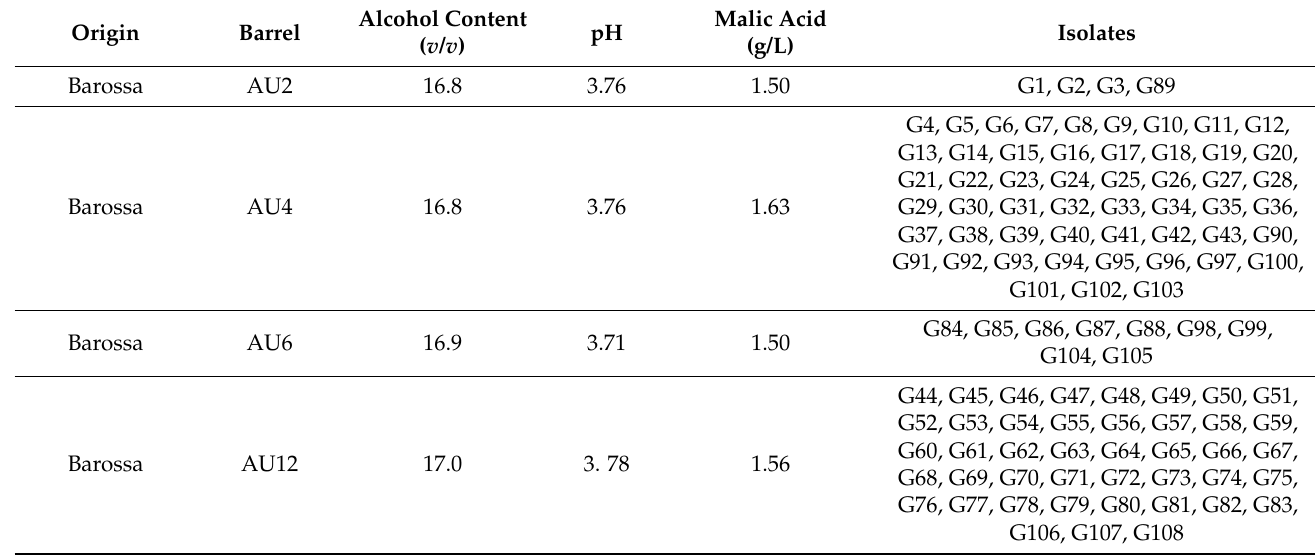
Table 1. Bacteria isolated from Grenache